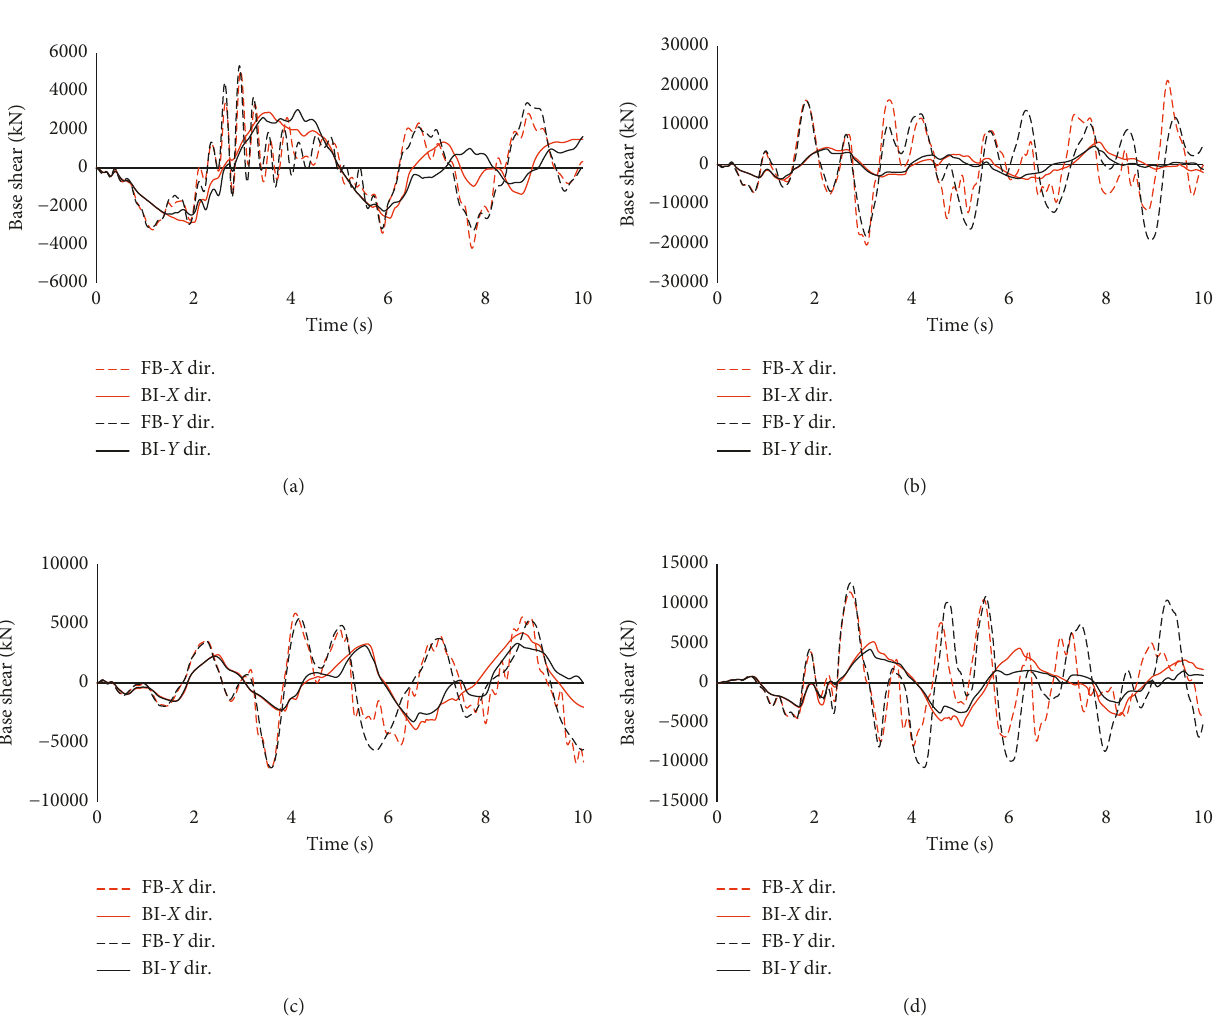
Figure 13: Base shear for FFB and FBI adjacent buildings under applied earthquakes. (a) Cape. (b) LACC-N. (c) S-Monica. (d) El-Centro. Table 6: Absolute base shear (kN) of the adjacent buildings under applied earthquakes. FFB Earthquake